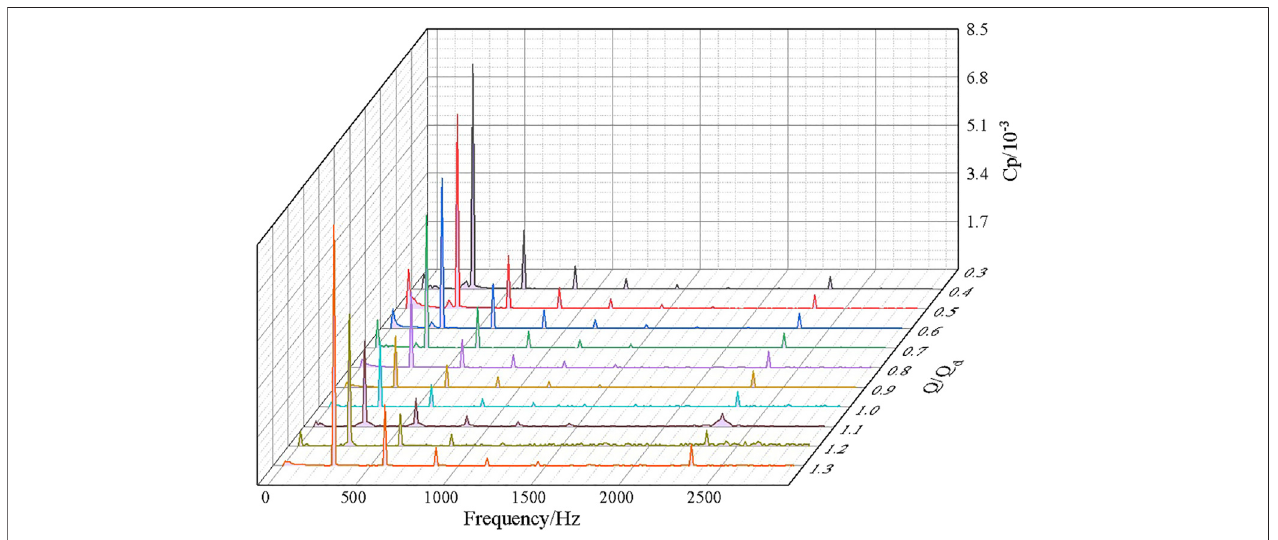
FIGURE 12 | Off-mode pulsation frequency domain